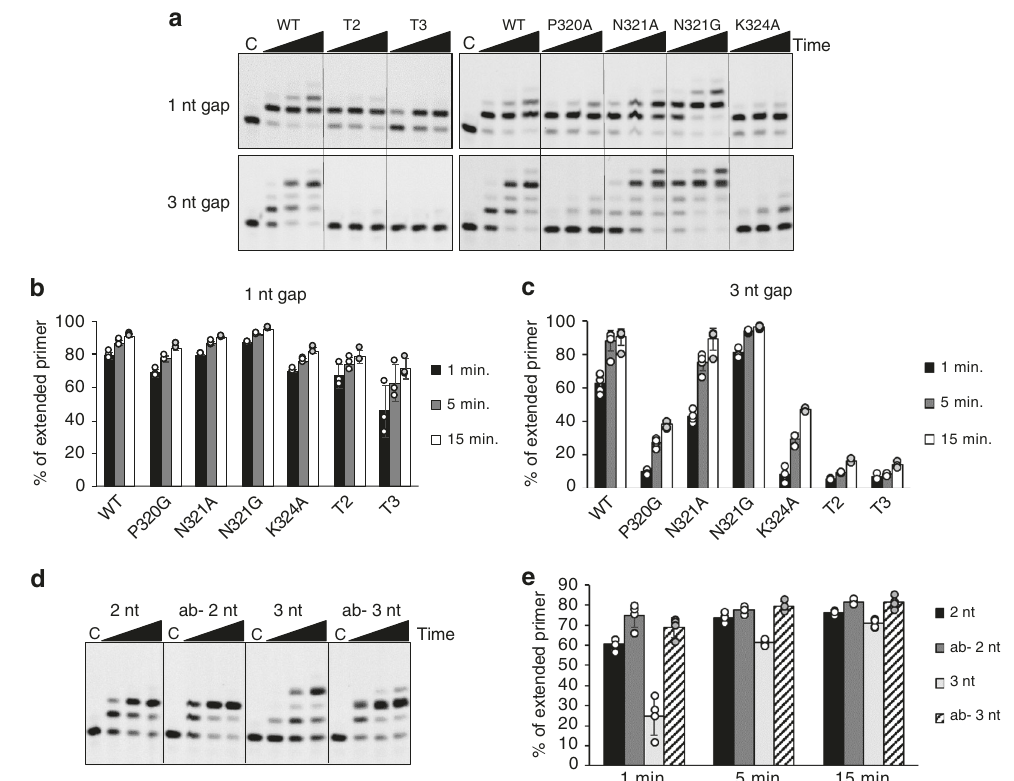
Fig. 4 Gap- fi lling activities of Loop 3 mutants. a Short gap- fi lling activities of selected Prim – PolC mutations. In primer extension assays, 30nM of 5 ′ - fl uorescein-labelled 36-mer containing a single-stranded 1-nt gap (top) or 3-nt gap (bottom) (with phosphorylation of the 5 ′ end of the downstream strand) was extended by Prim – PolC (300nM) in the presence of a 250 μ M rNTP mix for 1, 5 and 15min at 37°C. Control (C) lane contains no protein. b , c Quanti fi cation of the gap- fi lling assay (quanti fi cation of panel a ). d Gap- fi lling activity of Prim – PolC (WT) on an abasic (template − 2 position) 3-nt gap substrate. In primer extension assays, 30nM of 5 ′ - fl uorescein-labelled 36-mer containing different single-stranded gaps, with phosphorylation of the 5 ′ end, was extended by Prim – PolC (30nM) in the presence of a 250 μ M rNTP mix for 1, 5 and 15min at 37°C. Control (C) lane contains no protein. e Quanti fi cation of Prim – PolC primer extension on an abasic 3-nt gap substrate (quanti fi cation of panel e ). Data shown ( b , c and e ) are representative of the mean of at least three individual experiments, and error bars show the standard deviation, and dotplots show the corresponding data